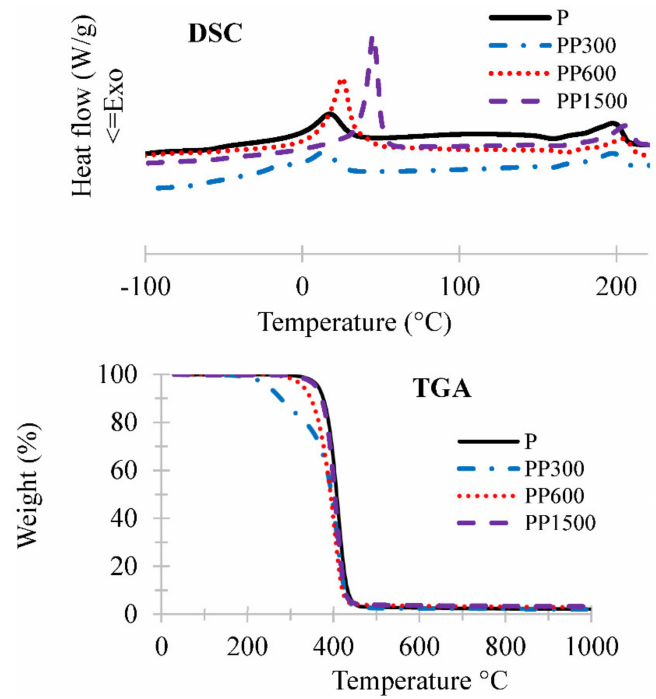
Figure 2. TGA and DSC curves of neat Pebax and Pebax/PEG